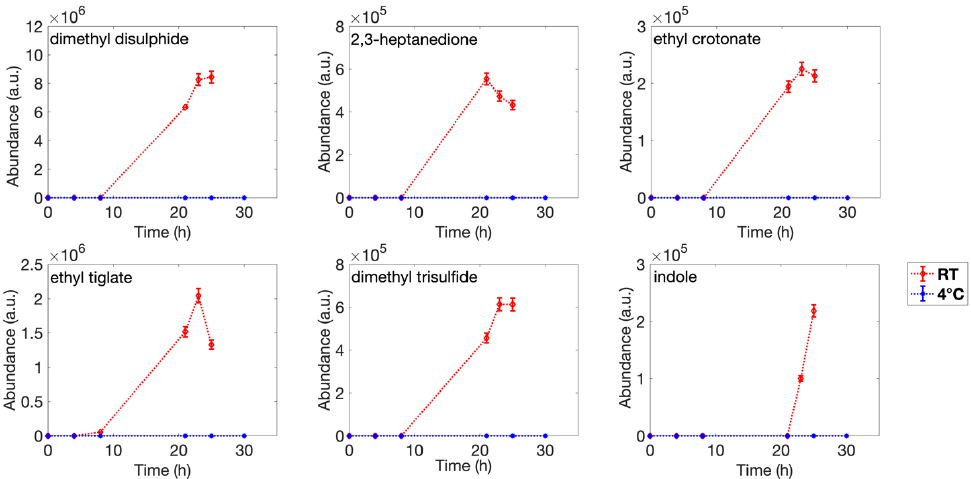
Figure 4. SPME-GC/MS analysis of meaningful compounds found only in the headspace of fish stored at room temperature (25 °C), related to storage time.